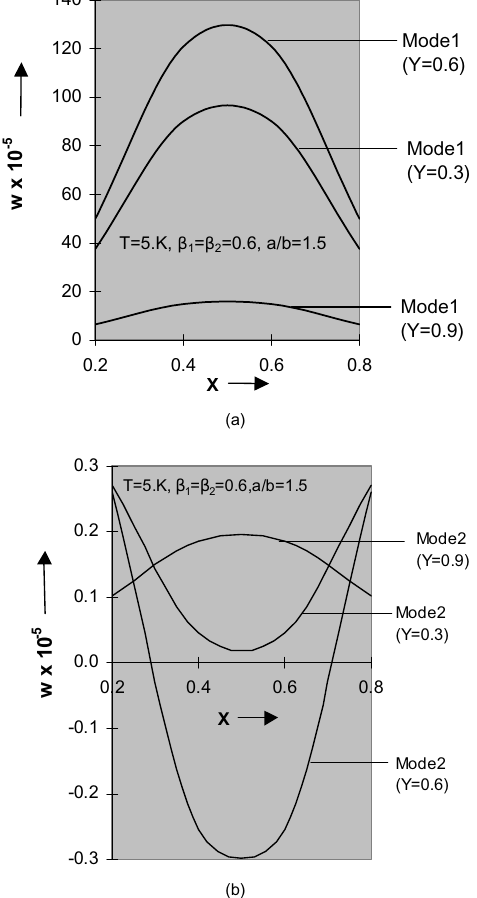
Fig. 7. (a) Deflection w vs X of a clamped visco-elastic rectangular plate (b) Deflection w vs X of a clamped visco-elastic rectangular